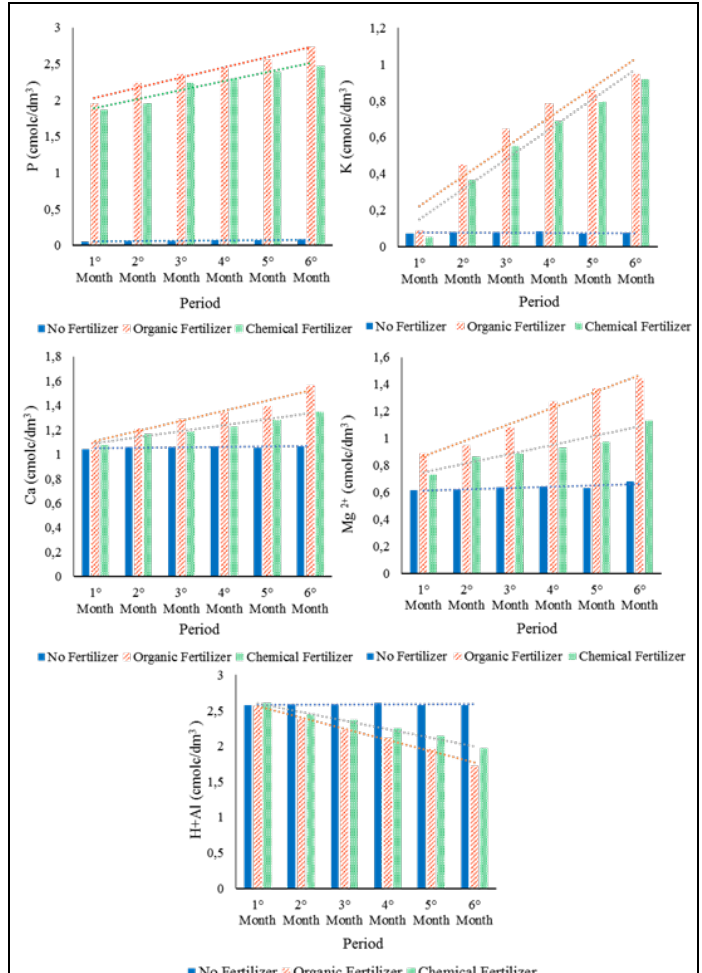
Figure 8: Representation graphical for the teors of phosphorus (P), potassium (K), calcium (Ca), magnesium (Mg) and potential acidity (H+Al) in function of the three treatments applied in the six-month study. Source: Authors,